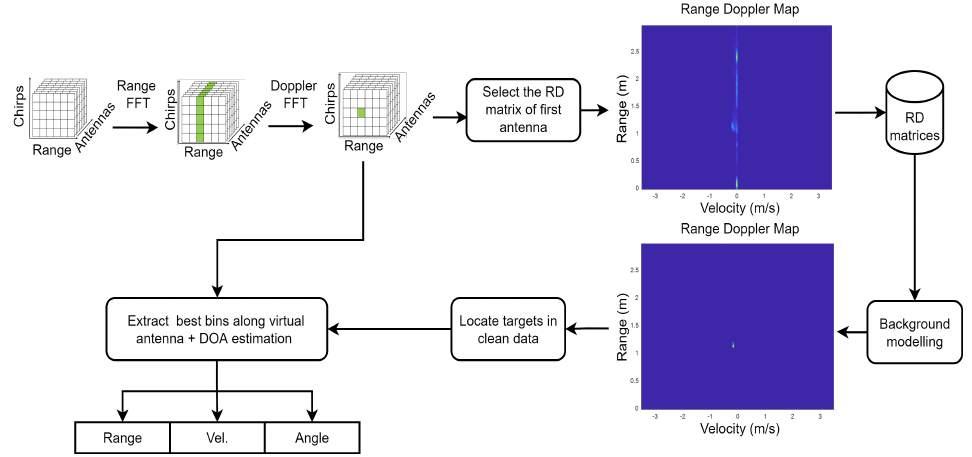
Figure 3. Processing chain for feature extraction from radar raw